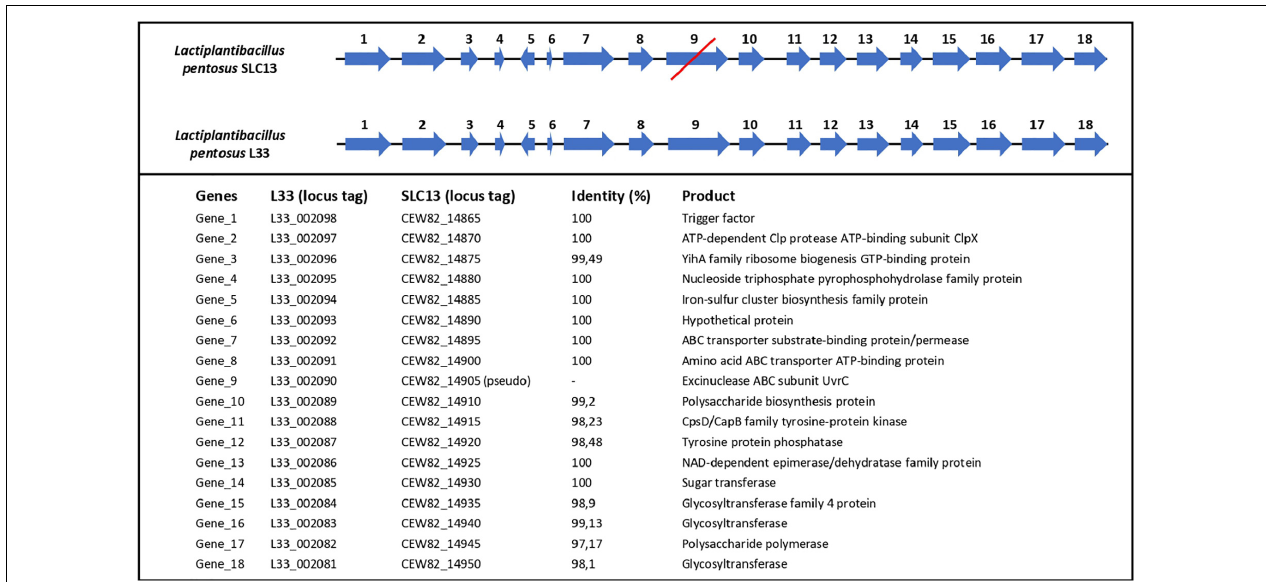
FIGURE 7 | Comparison of length, position and direction of genes comprising the EPS biosynthesis cluster of L. pentosus L33 and L. pentosus SLC13. Protein identities between the two strains are also displayed. The red line indicates that gene number 9 in L. pentosus SLC13 is a pseudogene.